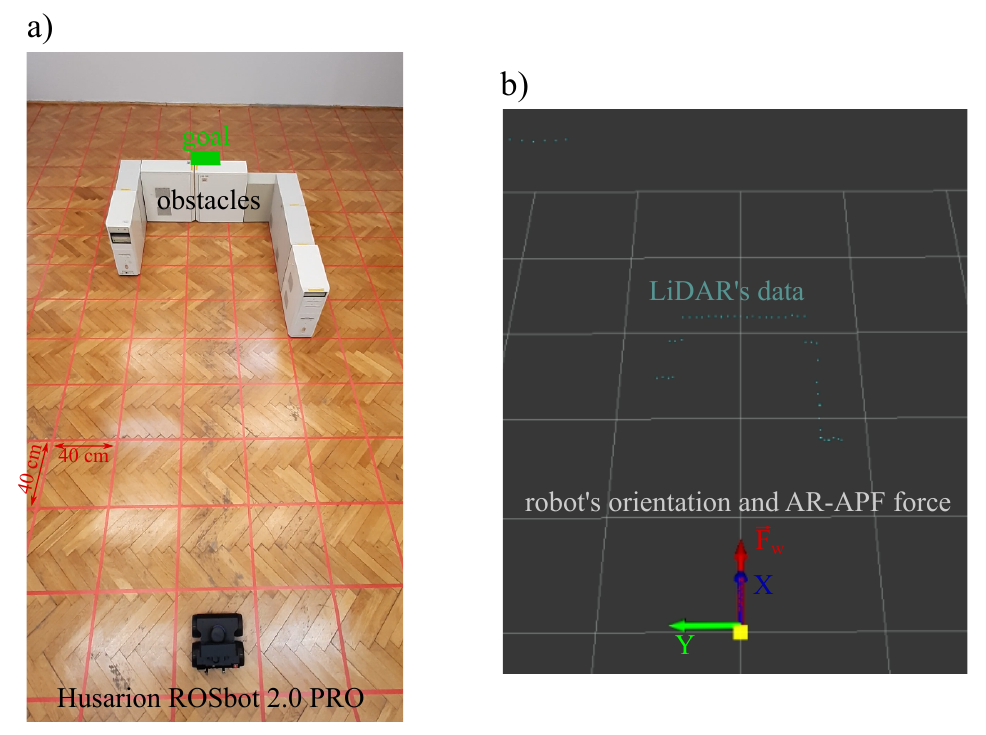
Figure 7. Laboratory environment: ( a ) photo of the laboratory stand, ( b ) robot’s perception on-line visualized by RViz.